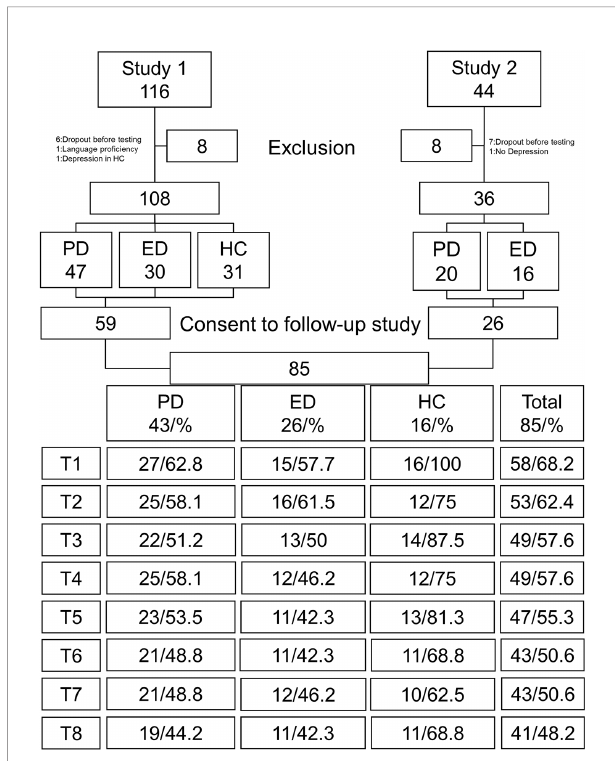
FIGURE 1 | Participant fl ow with participation rates for each point in time. ED, Episodic depression; HC, Healthy controls; PD, Persistent